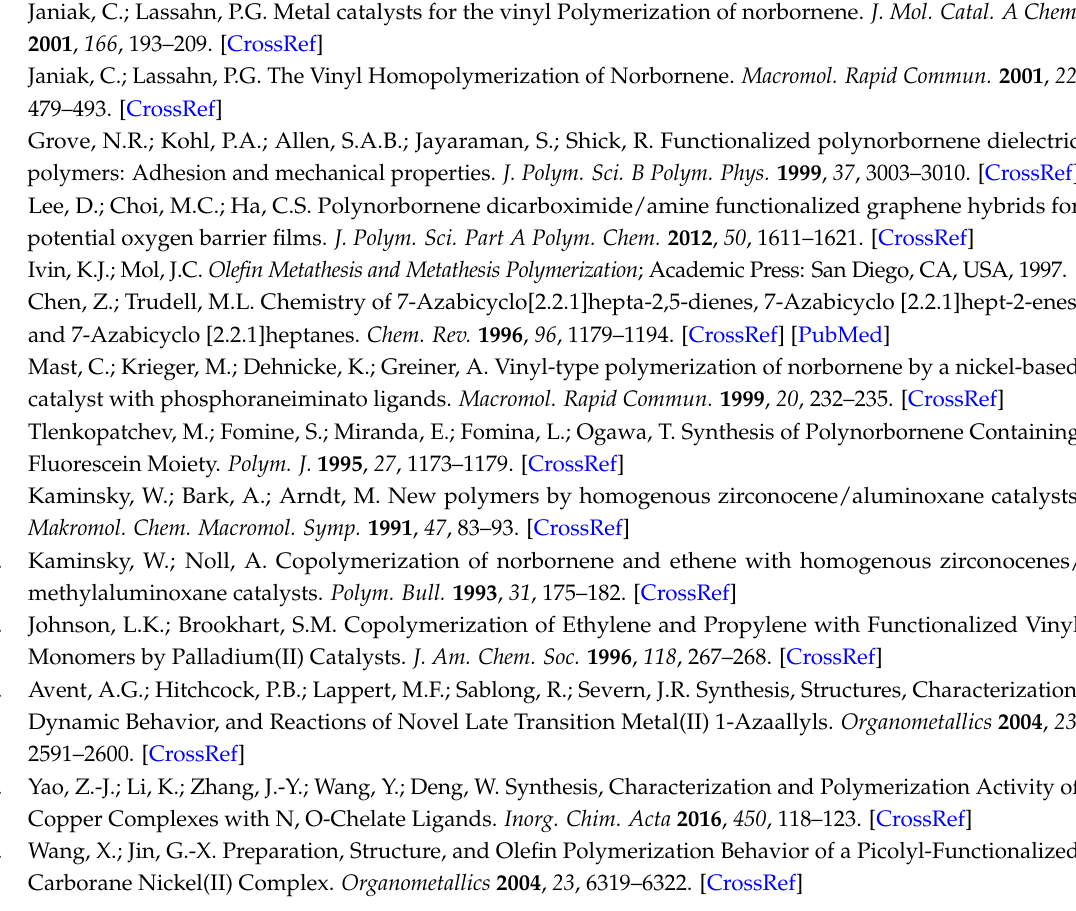
Figure S1: HRMS of complex 1 . Figure S2: HRMS of complex 2 . Figure S3: HRMS of complex 3 . Figure S4: HRMS of complex 4 . Figure S5: HRMS of complex 5 . Figure S6: TGA curves of complexes 1 – 5 . Figure S7: IR spectrum and 1 H NMR spectrum of PNB. Table S1: Selected Bond Lengths (Å) and Angles ( ◦ ) for Complexes 2 , 4 , and 5 . Table S2: Crystal data for Complexes 2 , 4 , and 5